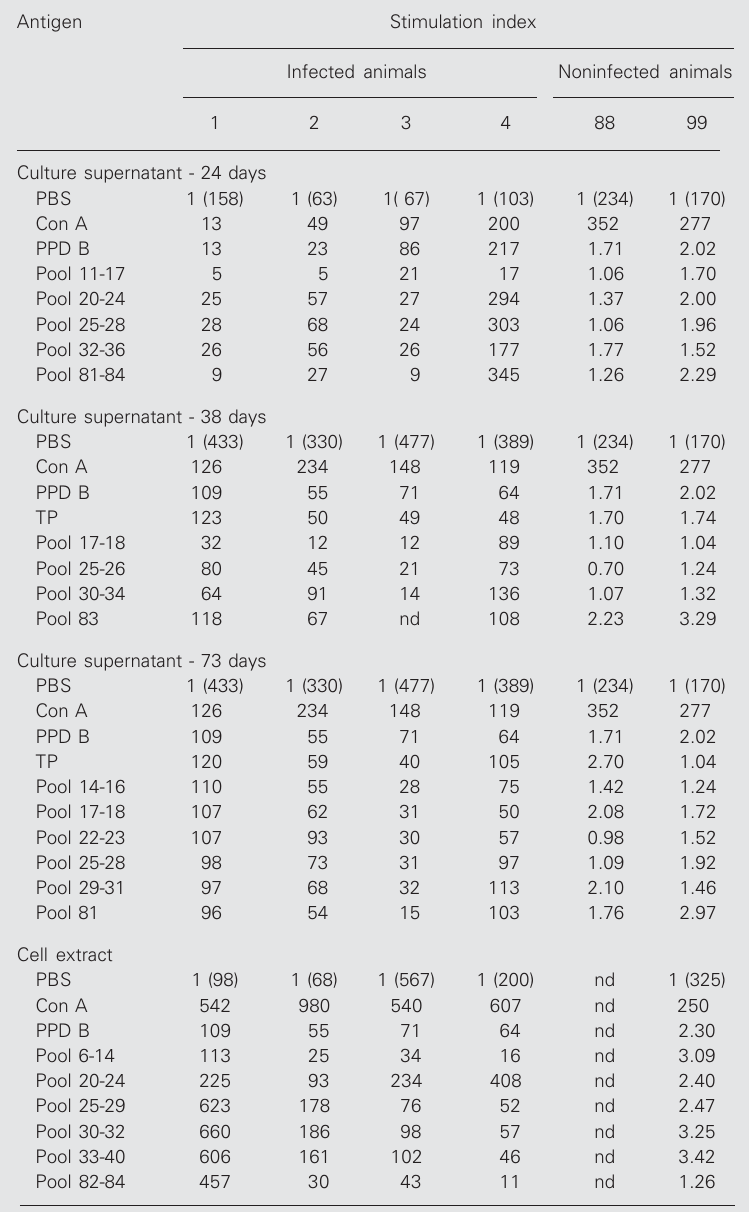
Table 1. Stimulation indices obtained in a lymphoproliferation